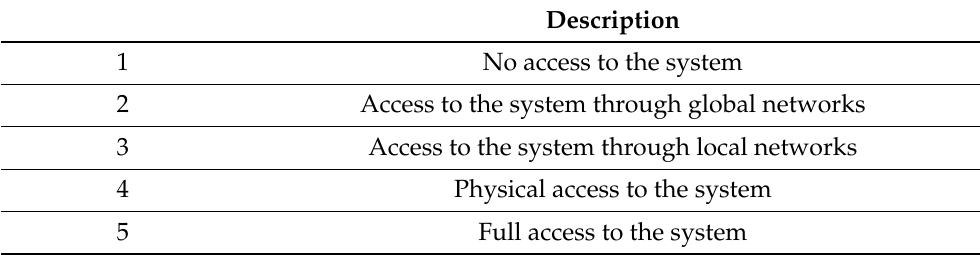
Table 2. Attacker types of access.